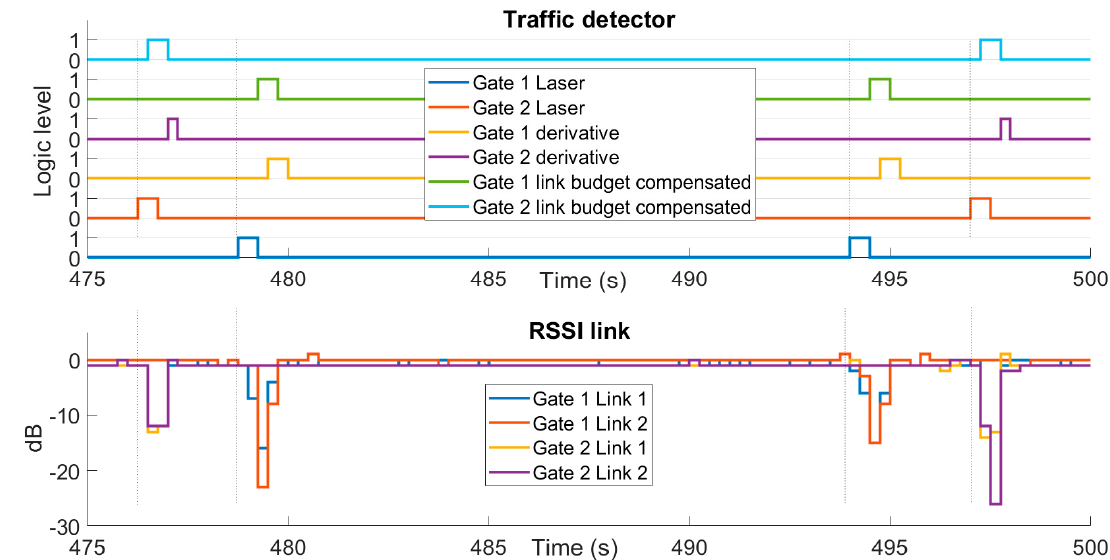
Figure 16. Above, it is shown the digital signals achieved after to apply the data analysis method compared with laser signals. Below are RSSI signal variations over 0 dB. Both graphics correspond with 30 km/h of car velocity and 20 m between gates.